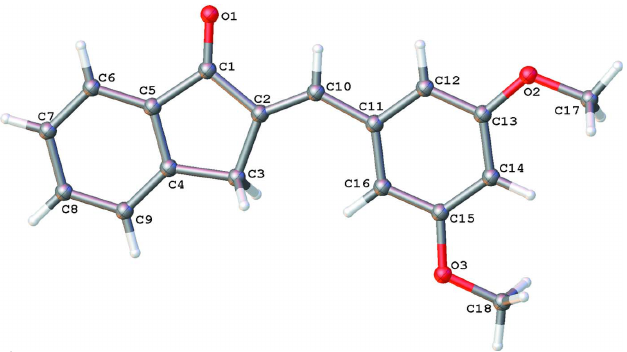
Figure 2 Displacement ellipsoid plot of 1b. Ellipsoids are drawn at the 50% probability level.